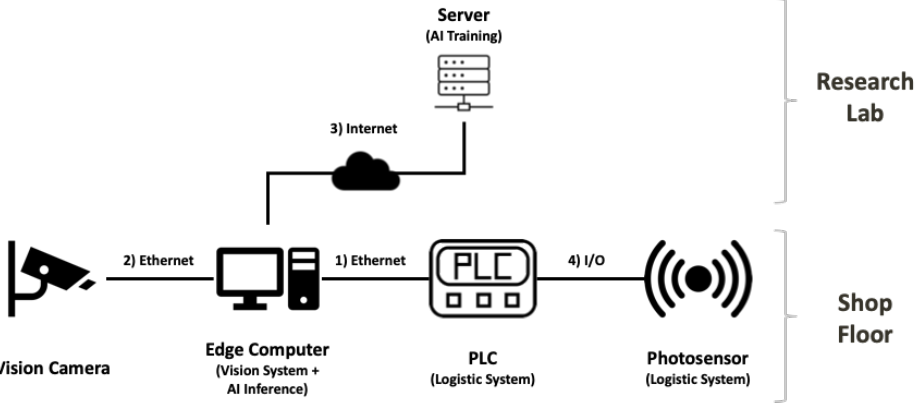
Figure 9. Network configuration of the proposed system.